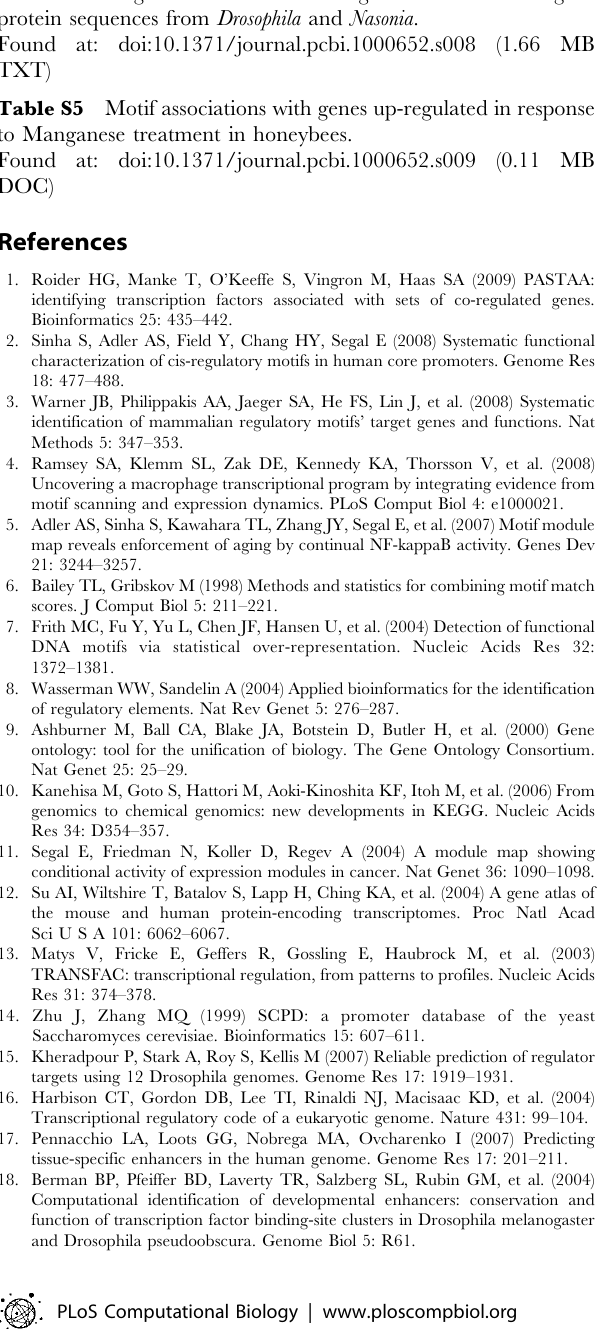
Table S2 Possible motif conservation scores and their semantics. See text for explanation of how.